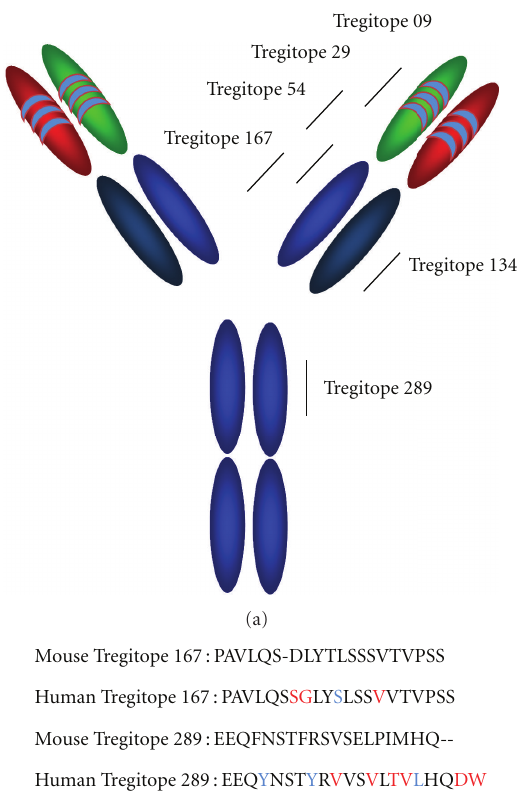
Figure 1: (a) Approximate location of IgG “Tregitopes” EpiVax murine and human Tregitope peptides. (b) Human and mouse Tre- gitopes are highly conserved. The sequences in bold are considered the core Tregitope sequence and di ff erences are color